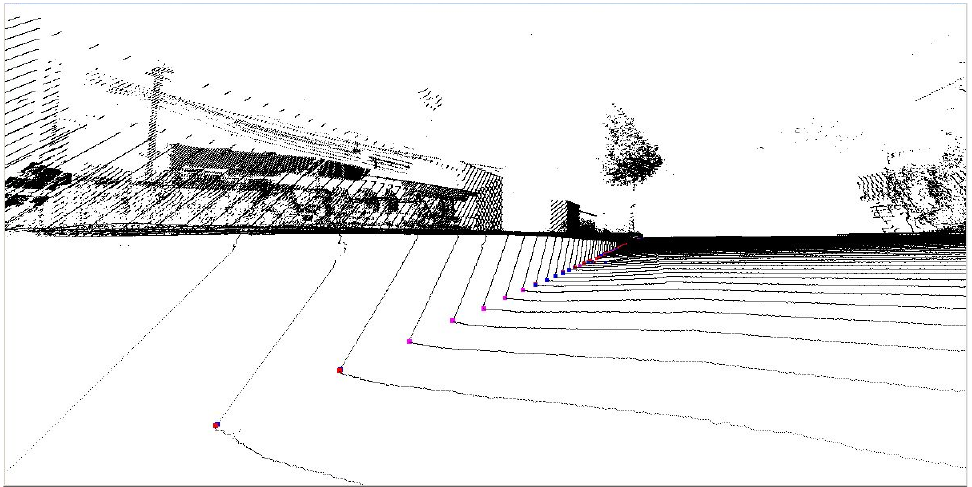
Figure 16: An example of manually extracted boundary points (red) and boundary points by our proposal (blue). Magenta color means that the position of both boundary point is match.